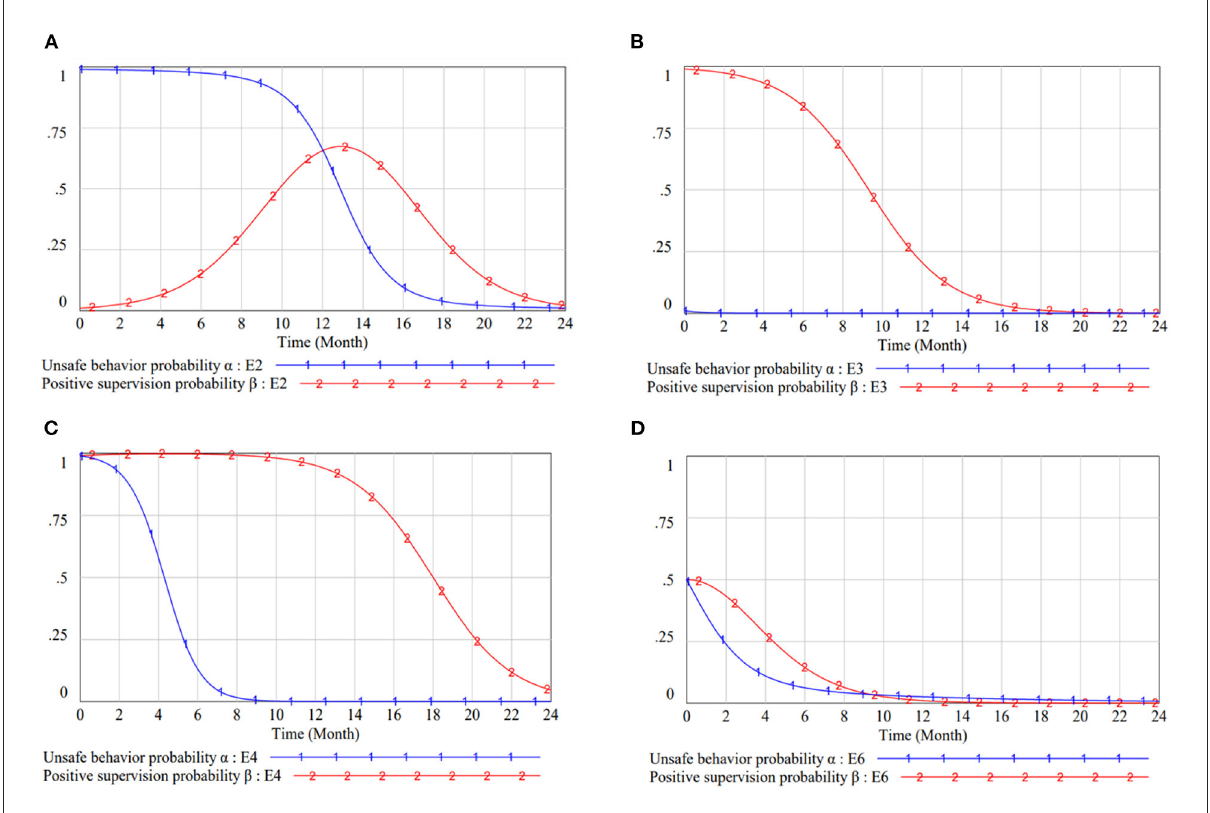
FIGURE5 Evolutionary path of different initial strategies. (A) Evolutionary path of initial strategy (1, 0). (B) Evolutionary path of initial strategy (0, 1). (C) Evolutionary path of initial strategy (1, 1). (D) Evolutionary path of initial strategy (0.5,